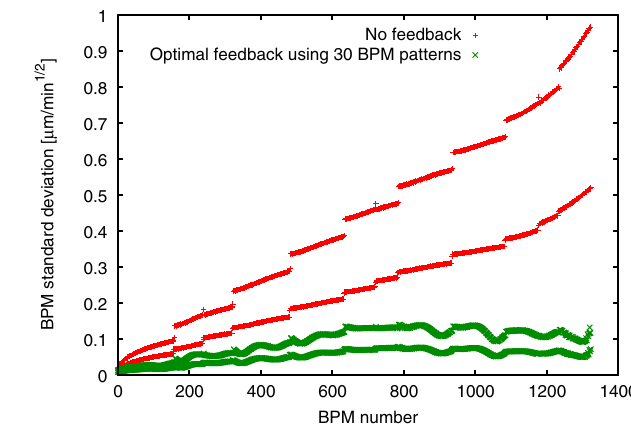
FIG. 10. (Color) Theoretical standard deviation of BPM read- ings for a large number of seeds. A feedback system based on 30 BPM patterns could ideally [if Eq. (65) could be solved exactly] reduce deviations efficiently.